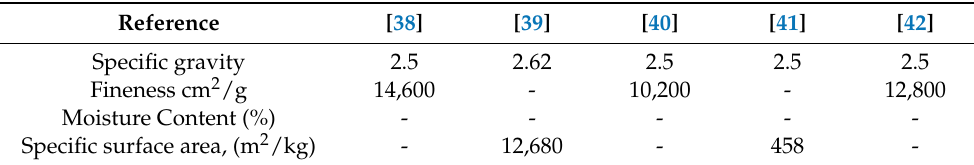
Table 1. The physical properties of Metakaolin (MTK).